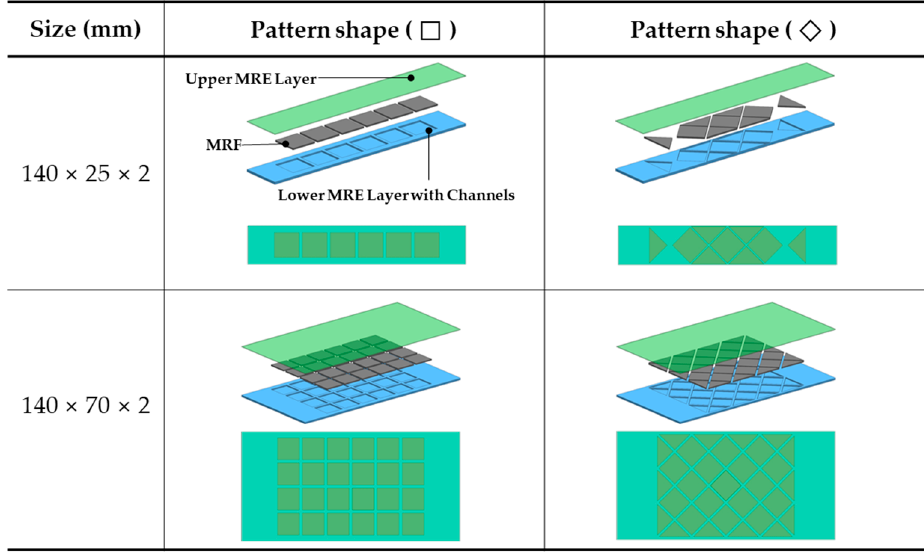
Figure 2. Schematic configuration of the soft composites fabricated from magnetorheological elastomer (MRE) layers and magnetorheological fluid (MRF). (MRE) layers and magnetorheological fluid